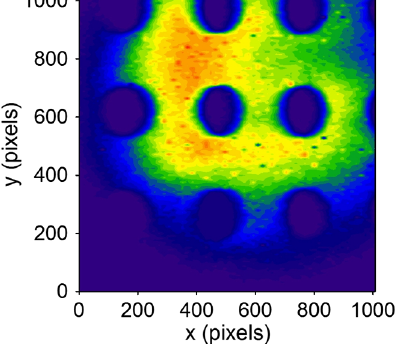
FIG. 8. Image of the calibration target. The increased vertical resolution at the expense of the horizontal is clearly visible.